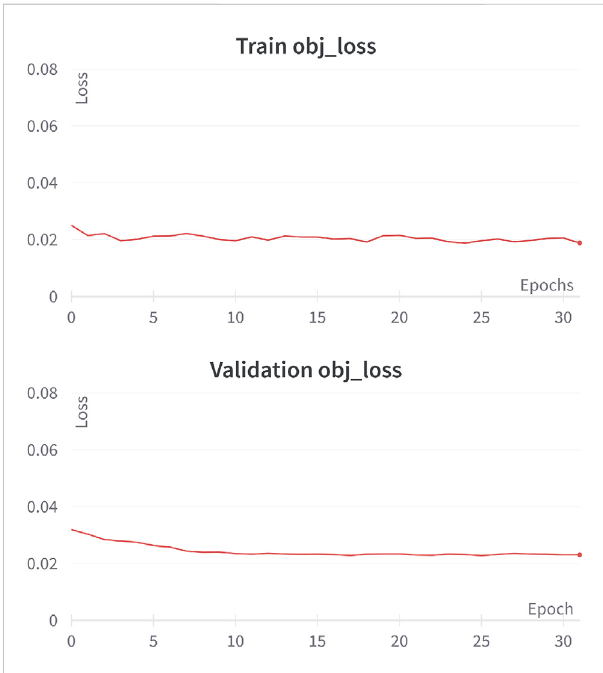
FIGURE 12 Training and validation performances in the object loss function during 31 epochs.